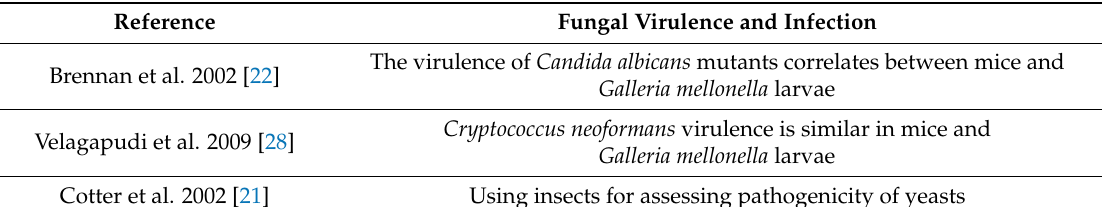
Table 1. Selected examples of utilization of G. mellonella larvae to assess fungal